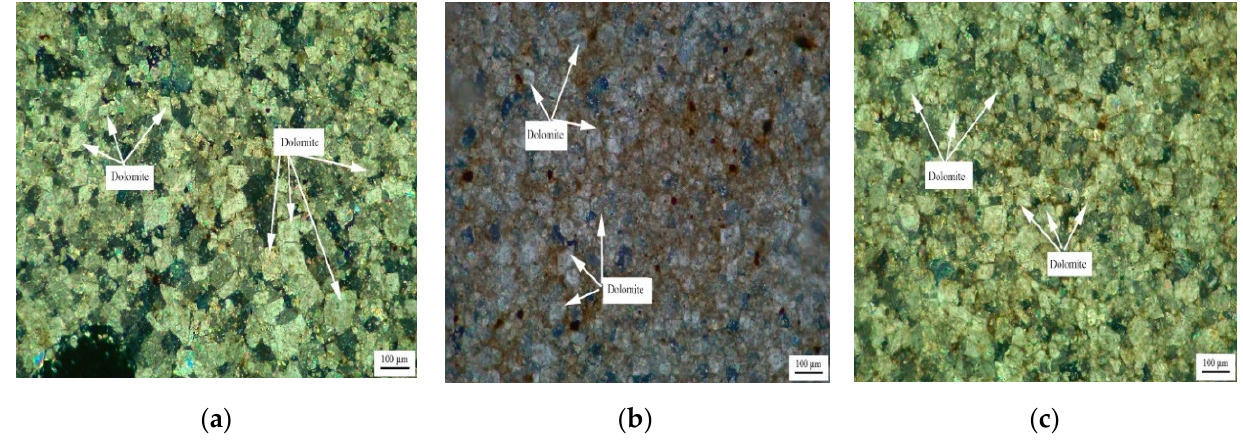
Figure 6. Distribution of dolomites in Devonian rocks ( a ) SFP-1, ( b ) SFP-2, and ( c ) SFP-3.